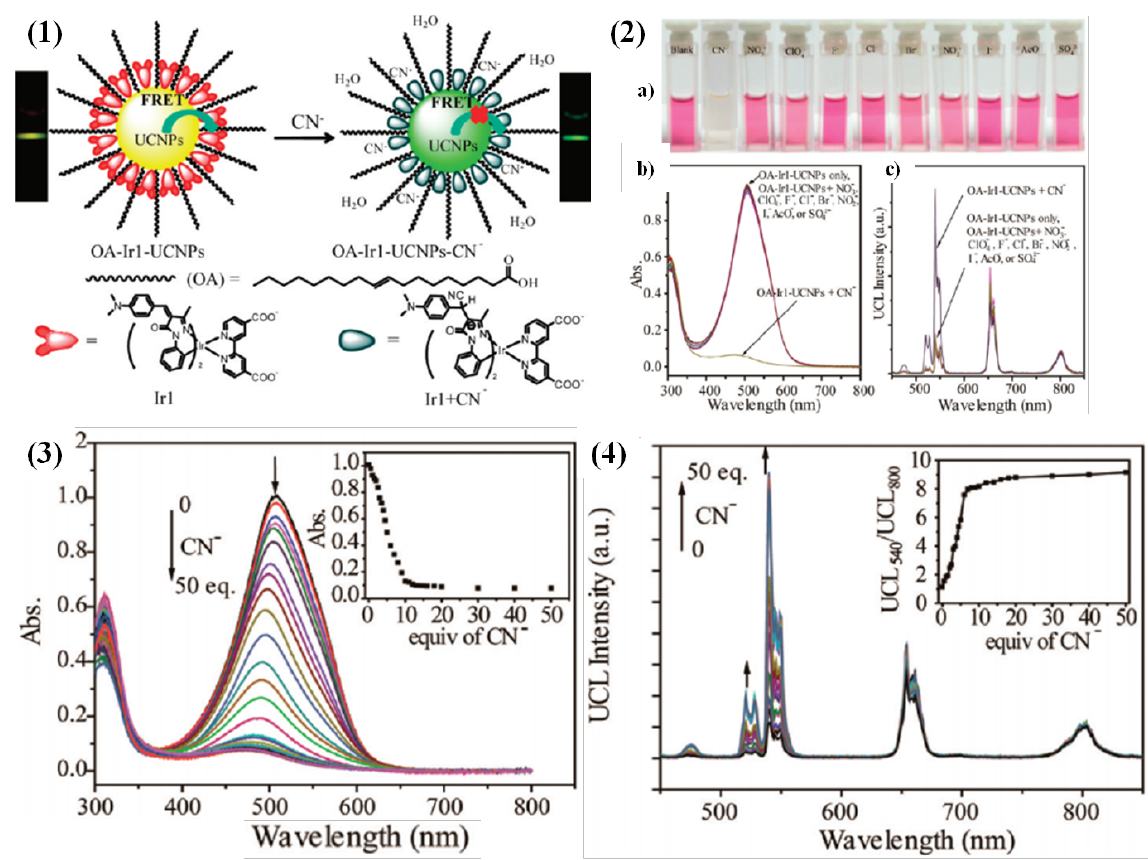
Figure 12: (1) Proposed Recognition Mechanism and the FRET Process of OA-Ir1-UCNPs towards CN − . (2) The photos of color changes a) of the OA-Ir1-UCNPs upon addition of various anions, and absorption spectra b) and UCL spectra c) of OA-Ir1-UCNPs in DMF/H 2 O solution upon addition of 1mM of different anions. Changes in absorption spectra (3) and UCL spectra (4) of 10 µ M OA-Ir1-UCNPs in DMF/H 2 O upon ad- dition of CN. Inset: the absorbance at 505 nm (3) and the ratio (I540/I800) of UCL intensities at 540 and 800 nm (4) of OA-Ir1-UCNPs as a function of CN − concentration. Excitation by CW 980 nm laser with a power density of 45 W cm −2